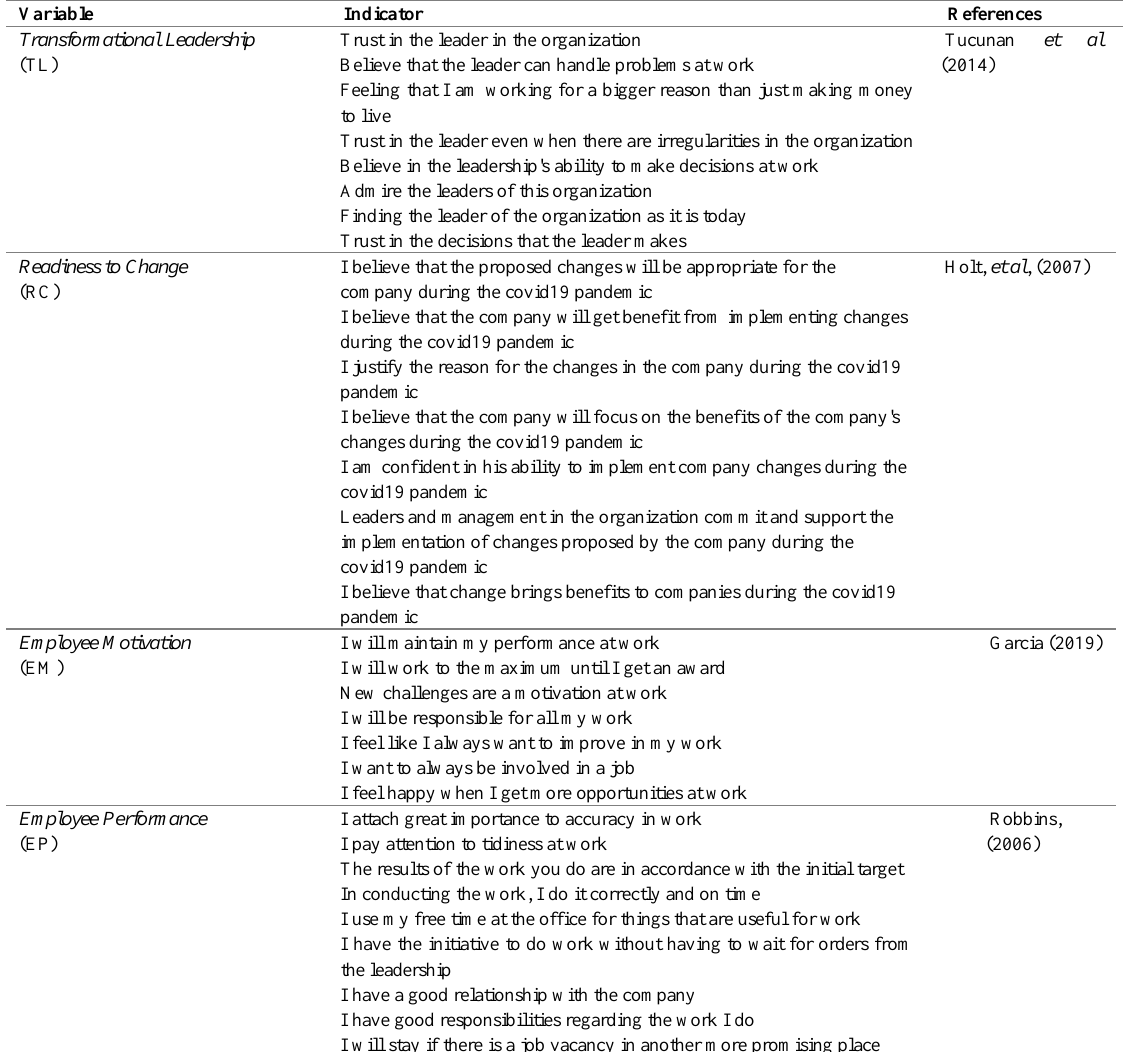
Table 1: Variable and Research